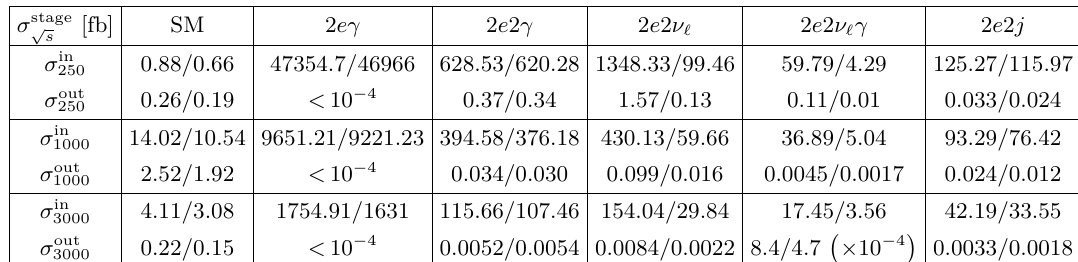
Table 5. Cross-sections, σ , in fb, for the ZBF -like SM-driven signal e + e − → e + e − h and its dominant backgrounds before ( in ) and after ( out ) event selection at We consider the left and right beam polarisations P (see text for details). For the t ¯ t , e + e − W + W − , and e + e − ZZ channels, σ in (in fb) ∼ 1.52/2.38, 15.03/2.69, and 0.04/0.02, respectively at 1 TeV. At 3 TeV, the respective numbers are 0.12/0.21, 29.84/3.88, and 0.08/0.05. For all cases, σ out < 10 − 4 fb. For space is not open for any of these three channels.